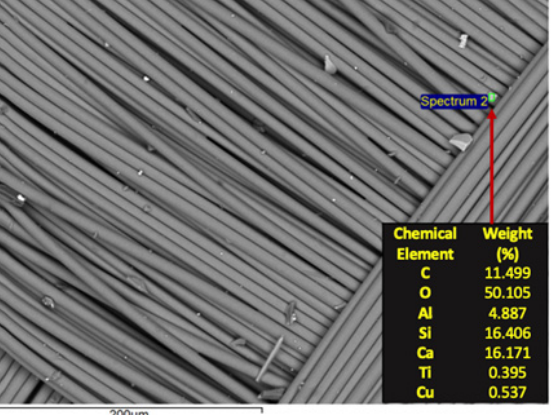
Figure 12. SEM/EDS characterization of the fiberglass recovered after the size separation.